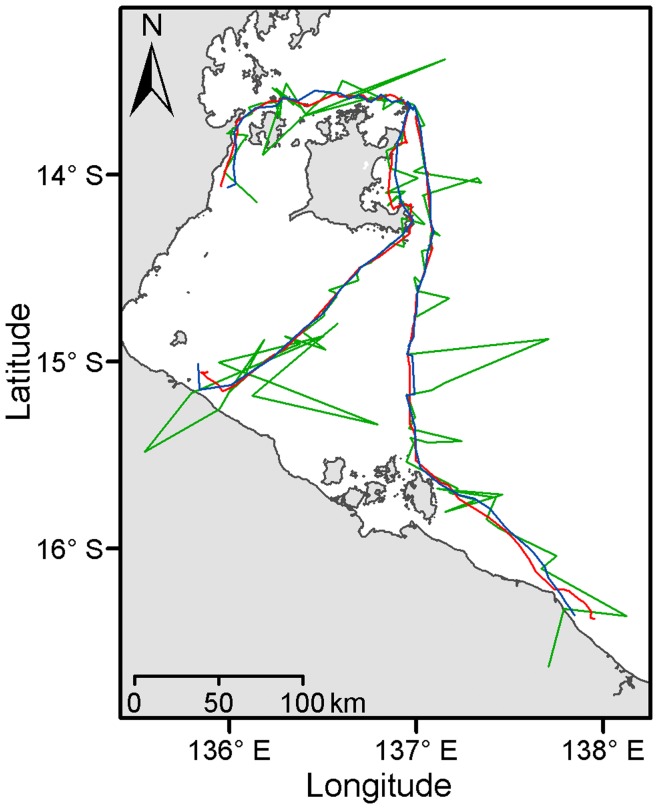
Migration tracks of three female hawksbill turtles using Fastloc GPS (red), post-processed SSM (blue) and Argos (green) locations.